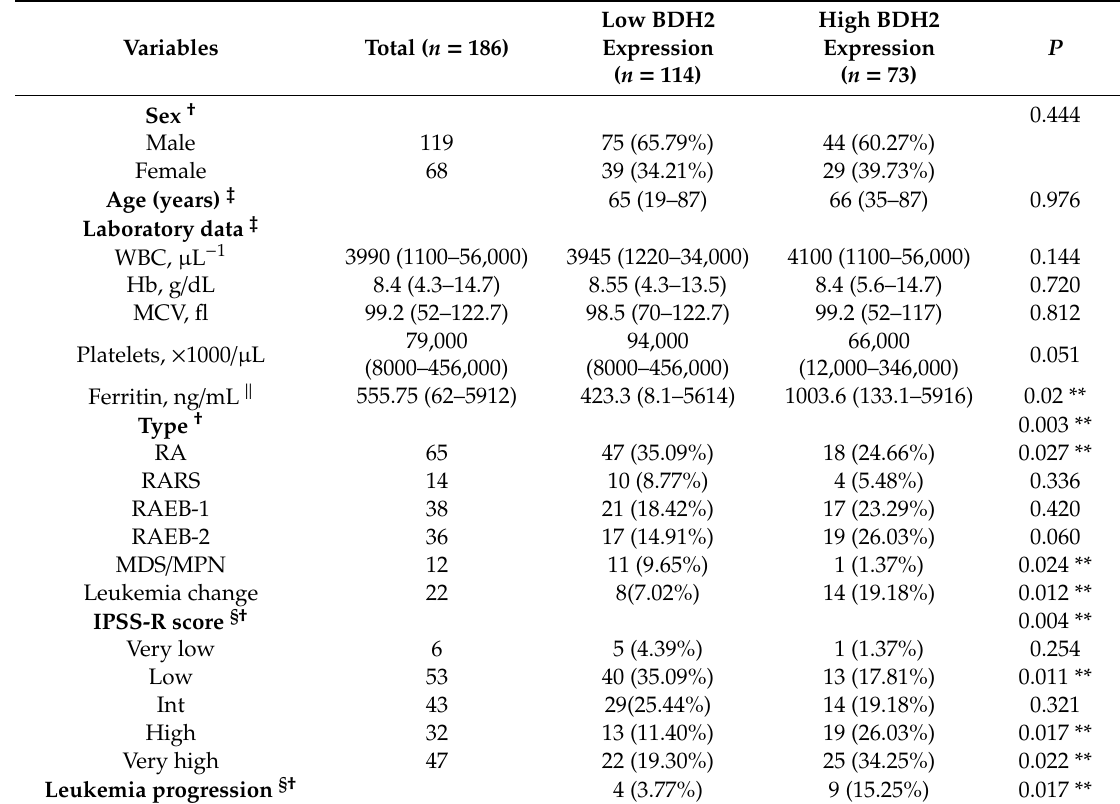
Table 1. Comparison of clinical manifestations and laboratory features in patients with MDS in low and high BDH2 expression groups